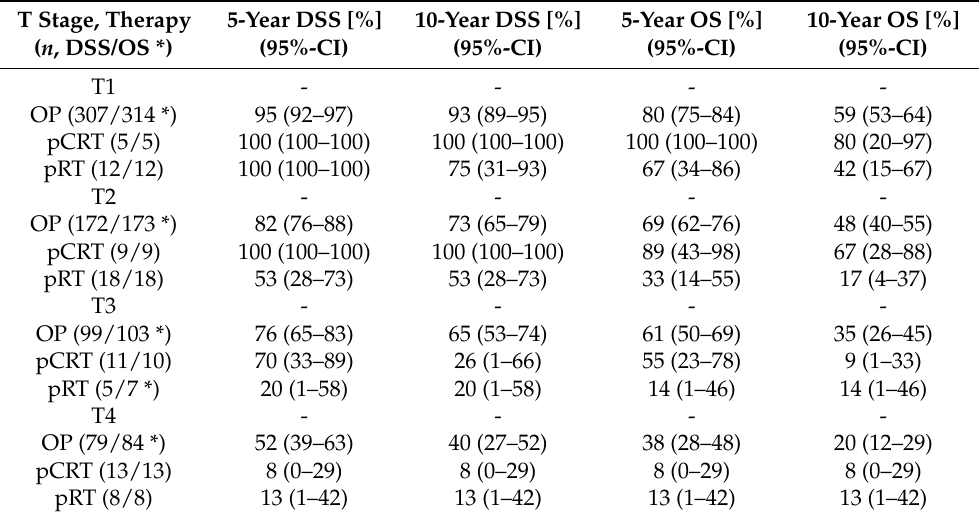
Table 2. Five- and 10-year DSS and OS of all laryngeal cancer patients of the cohort over T categories and